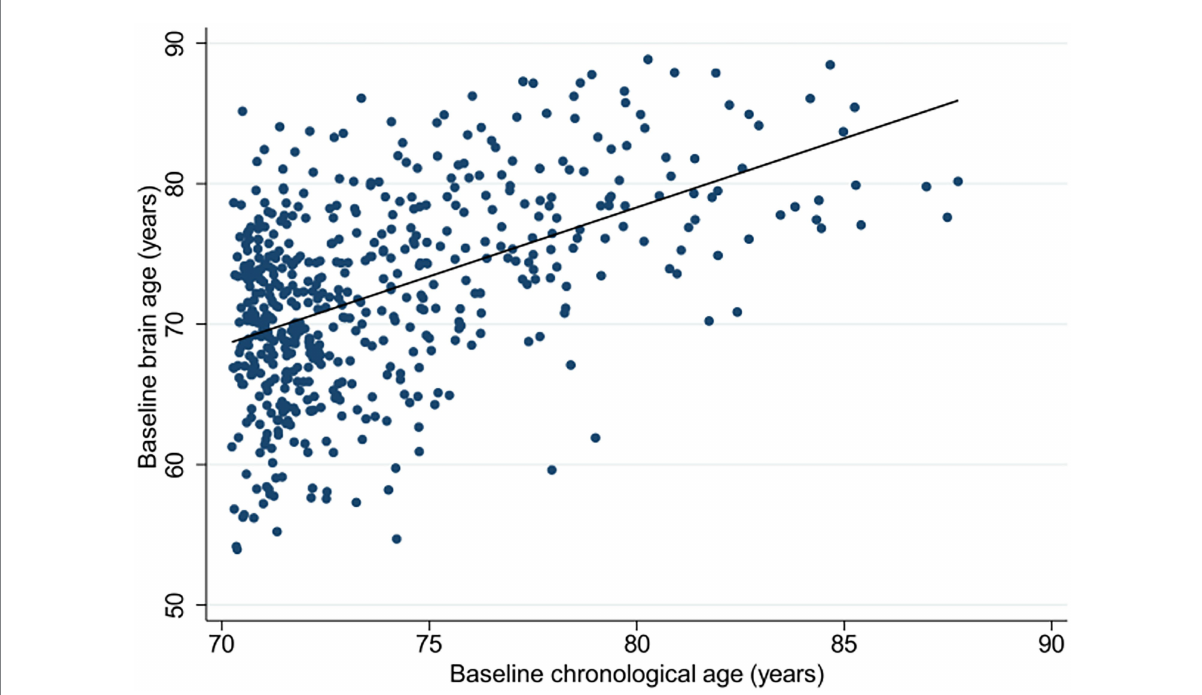
FIGURE 2 Scatterplot presenting the correlation between the estimated brain age (y-axis) and chronological age (x-axis), measured at baseline for the total NEURO cohort ( n =